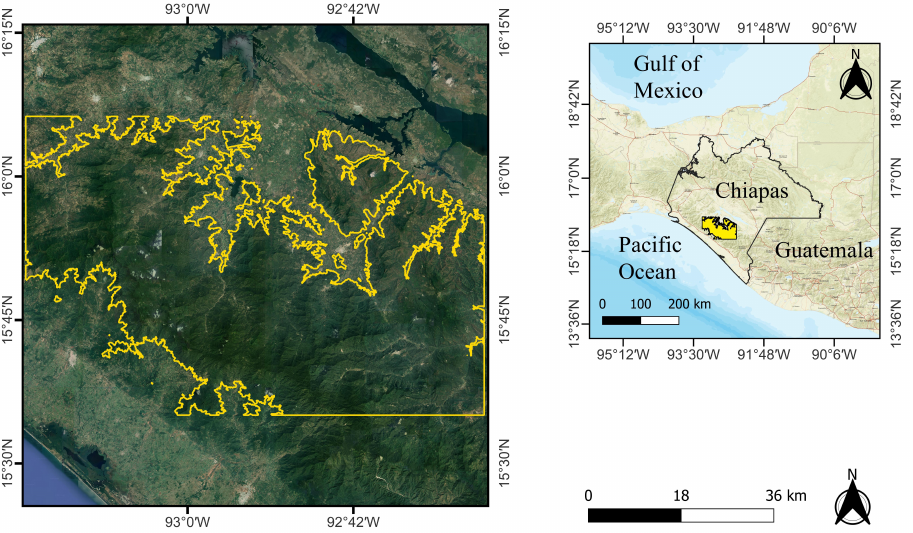
Figure 1. Location of the study area. Source: World Imagery, ESRI, Copyright: © 2022 Esri, Digi- talGlobe, GeoEye, i-cubed, USDA FSA, USGS, AEX, Getmapping, Aerogrid, IGN, IGP, swisstopo, and the GIS User